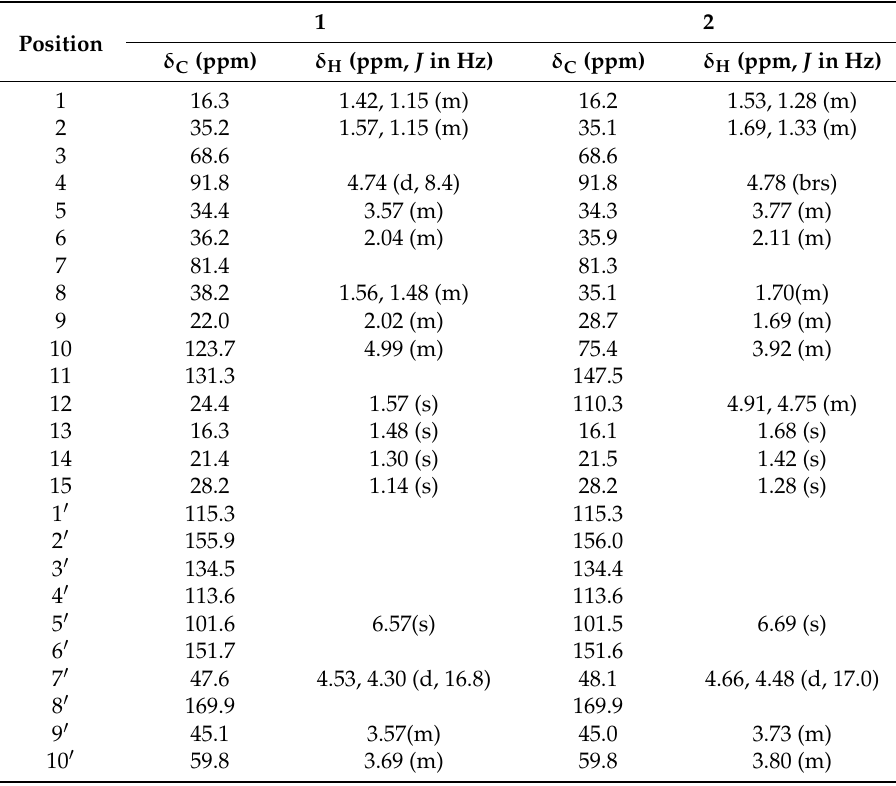
Table 1. 1 H and 13 C NMR spectral data of nitrobisabosquals A ( 1 ) and B ( 2